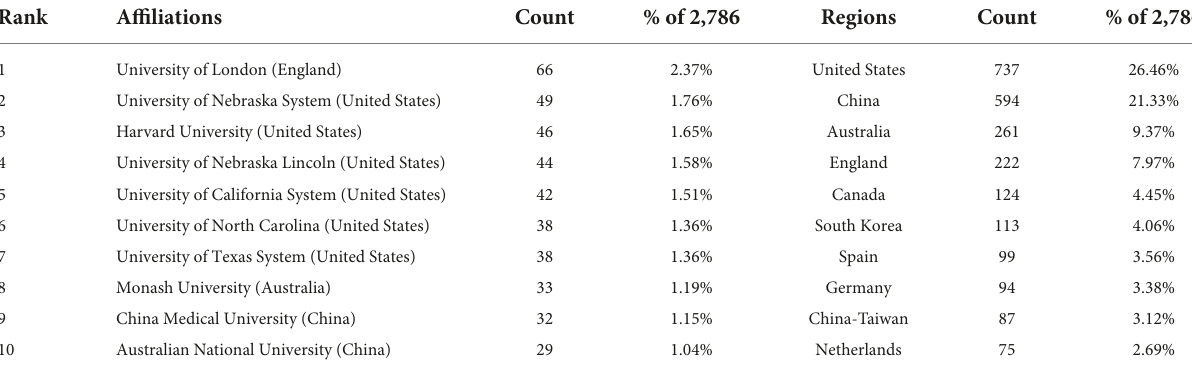
TABLE 2 The top 10 most-productive affiliations and